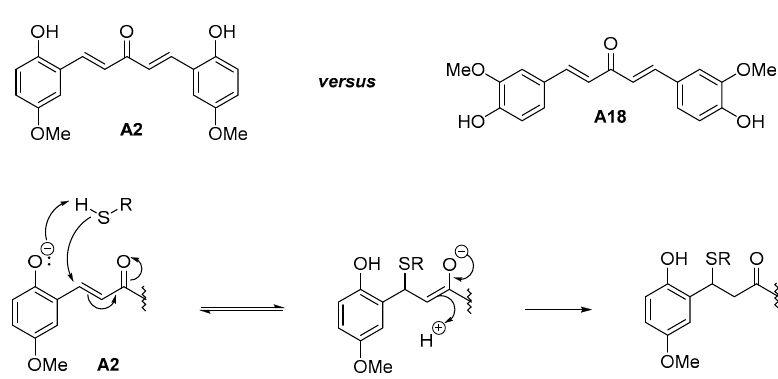
Figure 2. Rate enhancement of the Michael addition of thiol to the enone group of ortho -hydroxyl-DAA, such as the A2 molecule. This effect could account for the increased antimalarial activity observed in A2 versus A18.